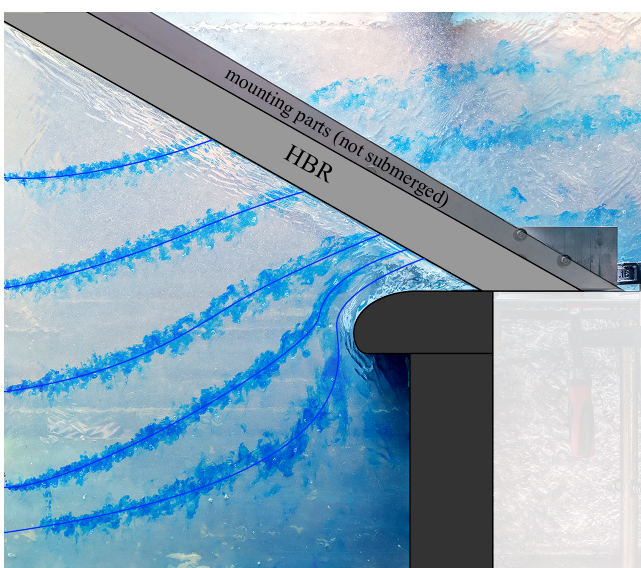
Figure 13. Visualization of the flow around the dividing pier at the downstream rack end with the configuration S4, α = 30 ◦ , s b = 20 mm, H Ov = 0, without spillway flow; field of view corresponds to dashed rectangle in Figure